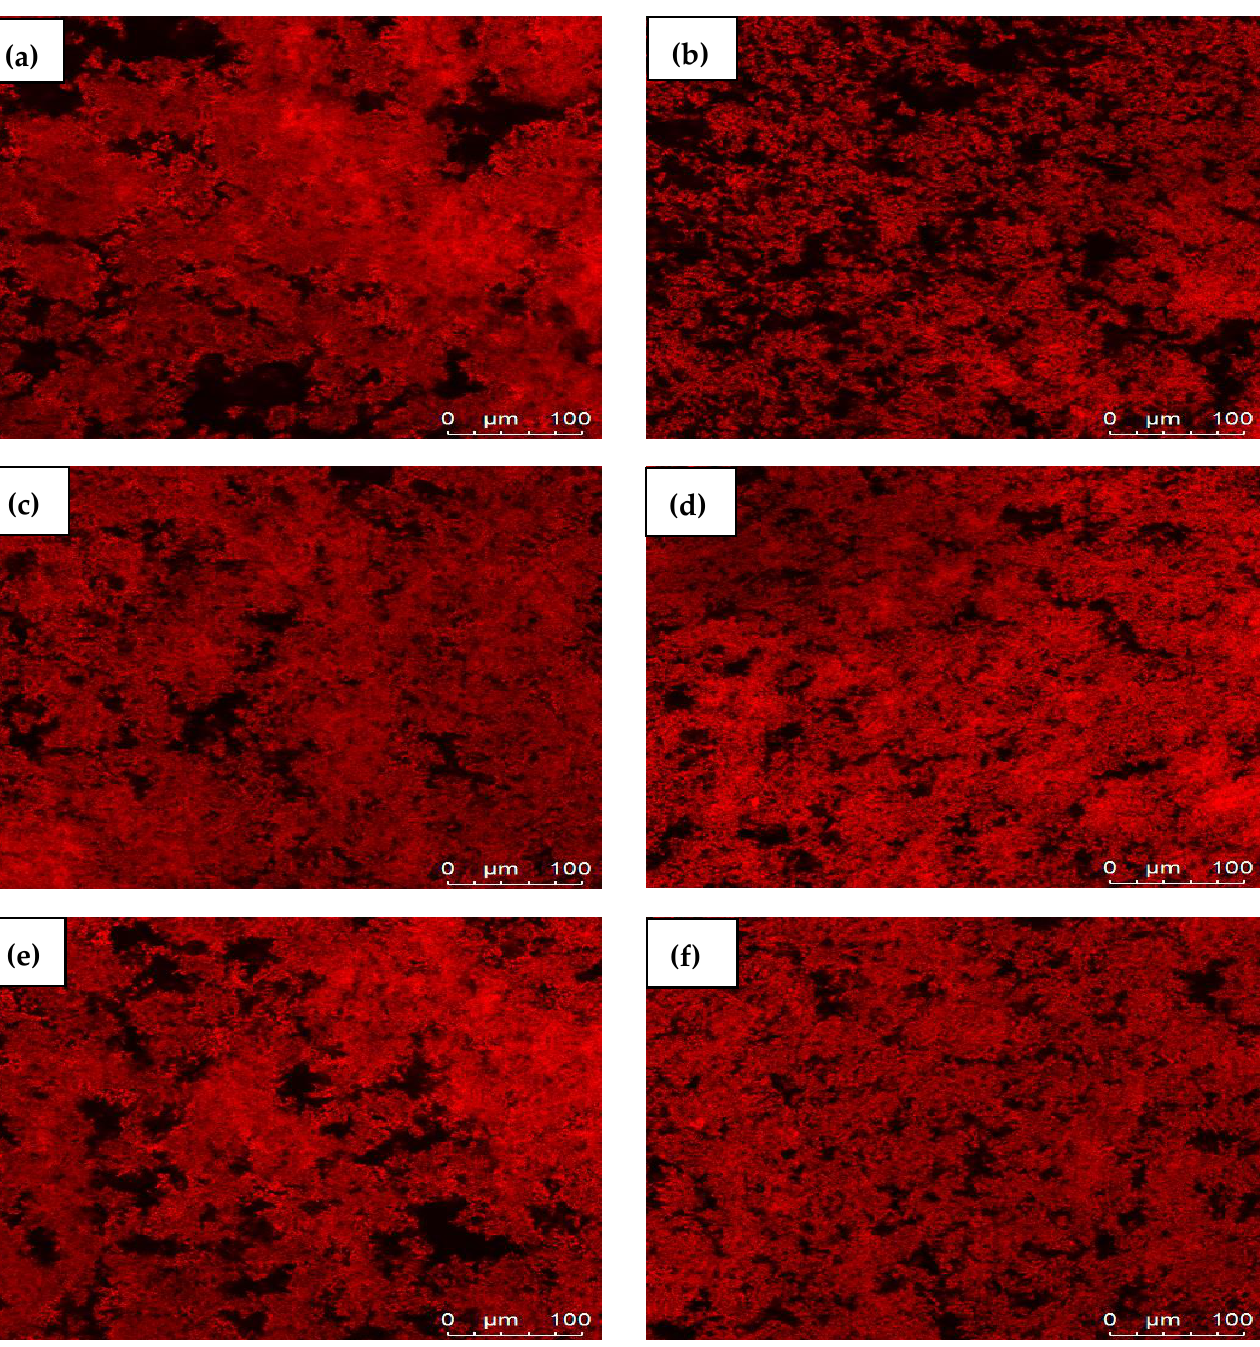
Figure 5. Microstructure of the homogenized and high-intensity thermosonicated stirred yoghurts of the homogenized goat milk ( a ), goat milk, high-intensity thermosonicated for 5 min ( b ), 10 min ( c ) and 15 min ( d ), homogenized cow milk ( e ) and cow milk, high-intensity thermosonicated for 15 min ( f ), captured by confocal laser scanning microscopy (CLSM) on the first day.